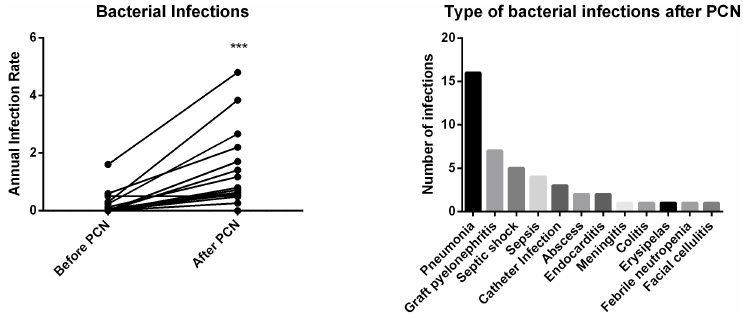
the diagnosis of PCN duringthe kidney transplantation period. ( *** = p < 0.001). B: Type (x axis) and number (y axis) of bacterialinfectionsduringthe follow-upof PCN. PCN: plasma cell